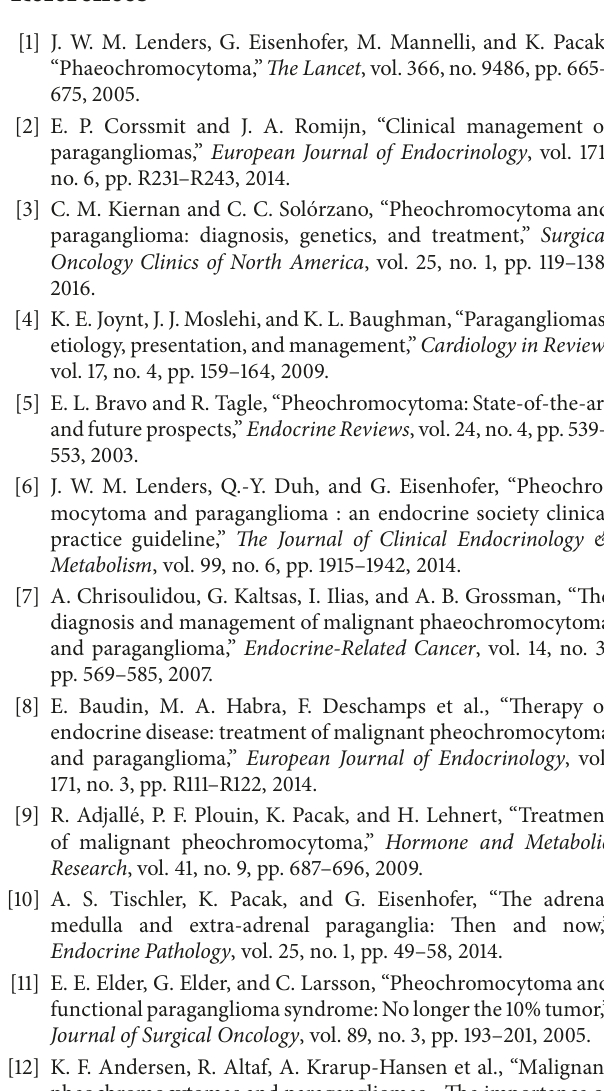
Supplemental Table 1: the top 50 features of Gene Set Enrichment Analysis based on metastasis in pheochromo- cytoma/paraganglioma from TCGA and COMETE cohort. Supplemental Table 2: the common differentially expressed (up/downregulated) genes (DEGs) extracted from TCGA and COMETE cohort. Supplemental Table 3: the 34 common differentially expressed (up/downregulated) genes (DEGs) validated in GSE67066 cohort. (Supplementary